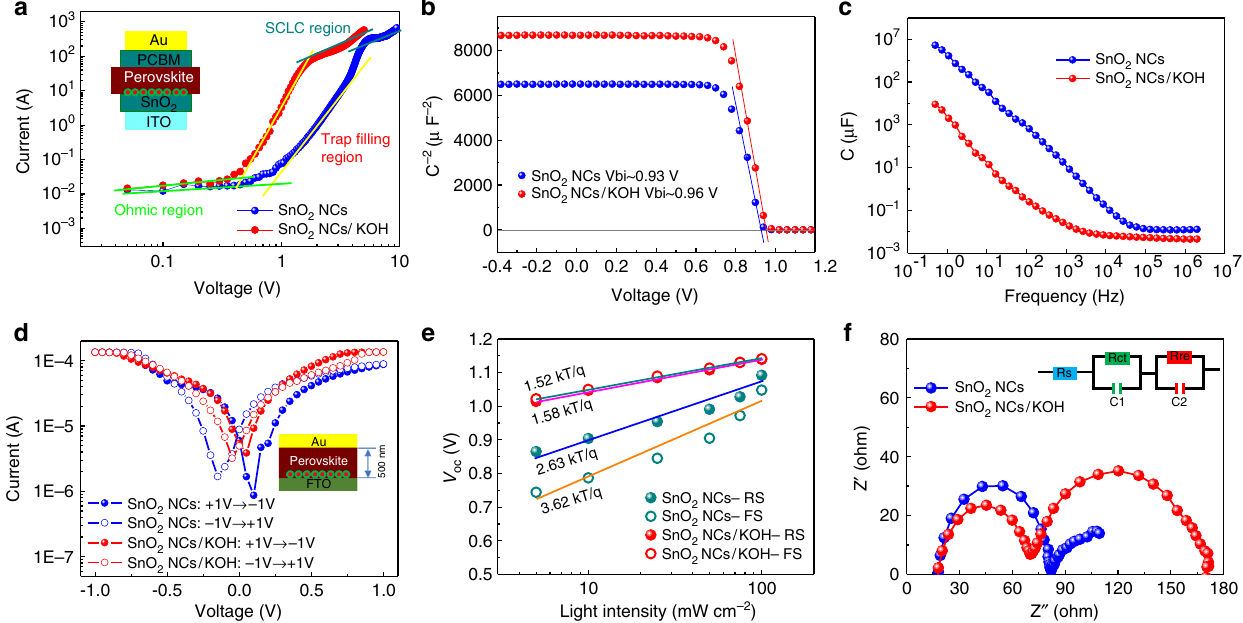
Fig. 5 Mechanism analysis of interface potassium passivation. a Dark J – V characteristics of electron-only devices with and without interface potassium passivation. The inset shows the structure of the corresponding electron-only device. b Mott – Schottky plots of PSCs with and without interface potassium passivation. c Capacitance – frequency plots of PSCs with and without interface potassium passivation. d The logarithmic I-V plots of the FTO/CsFAMA/Au and FTO/KOH/CsFAMA/Au device, respectively. The inset shows the structure of the corresponding device. e The V oc vs . Light Intensity curves of PSCs with and without interface potassium passivation and f the typical Nyquist plots of PSCs with and without interface potassium passivation. The inset shows the equivalent circuit